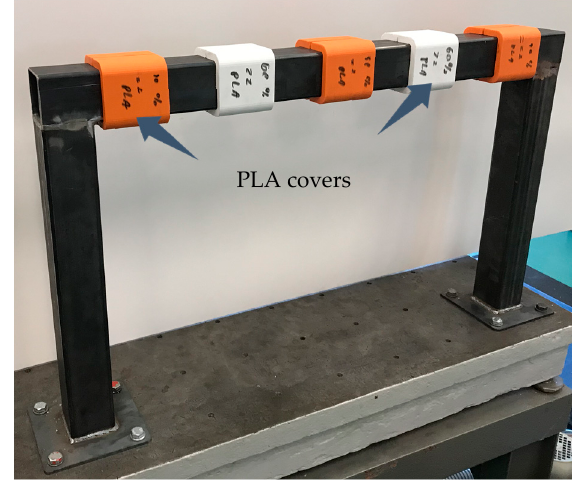
Figure 12. Distribution of the PLA covers.